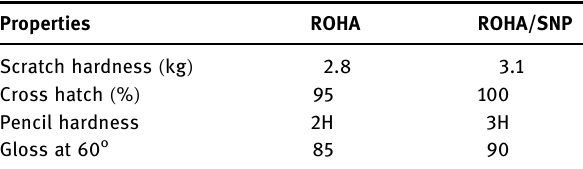
Table 1: Physicomechanical properties of ROHA and ROHA/SNP nanocomposite coatings